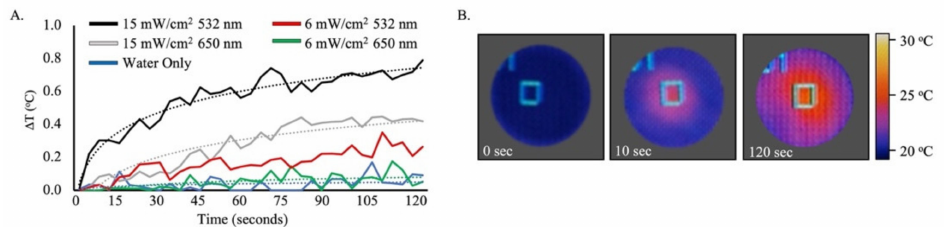
Figure 2. Heating properties of AuNP–mTHPC complex. ( A ) Temperature elevation of AuNP– mTHPC (0.1 mg/mL) as a function of irradiation time with the 650-nm (6 mW/cm 2 and 15 mW/cm 2 ) and 532-nm (6 mW/cm 2 and 15 mW/cm 2 ) lasers in an aqueous solution plotted with a trendline. ( B ) Examples of thermal images of AuNP–mTHPC monitored by an infrared camera at three time points (0, 10, and 120 s). The right scale represents the color code for surface